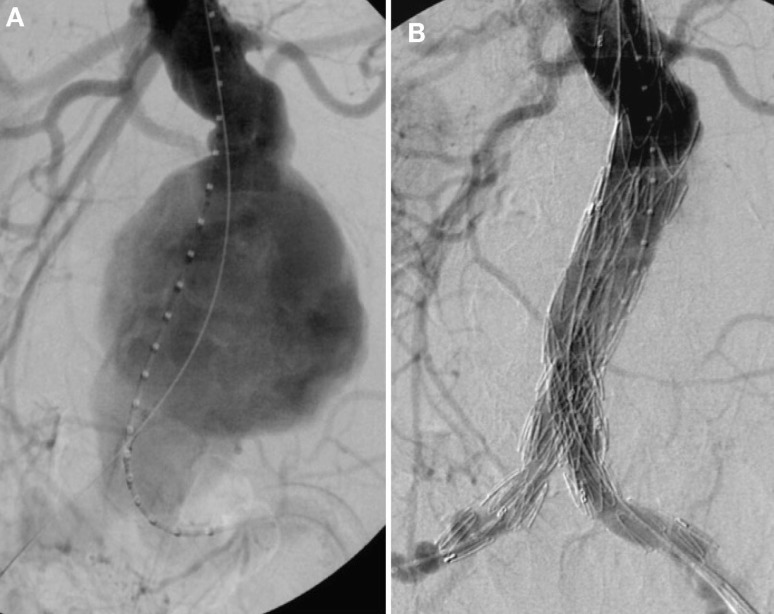
(A) Invasive angiography prior to endovascular repair (EVAR): rupture of an infrarenal AAA. (B) Final angiography after EVAR: successful exclusion of the ruptured AAA by a bifurcated stent graft; no endoleak visible.